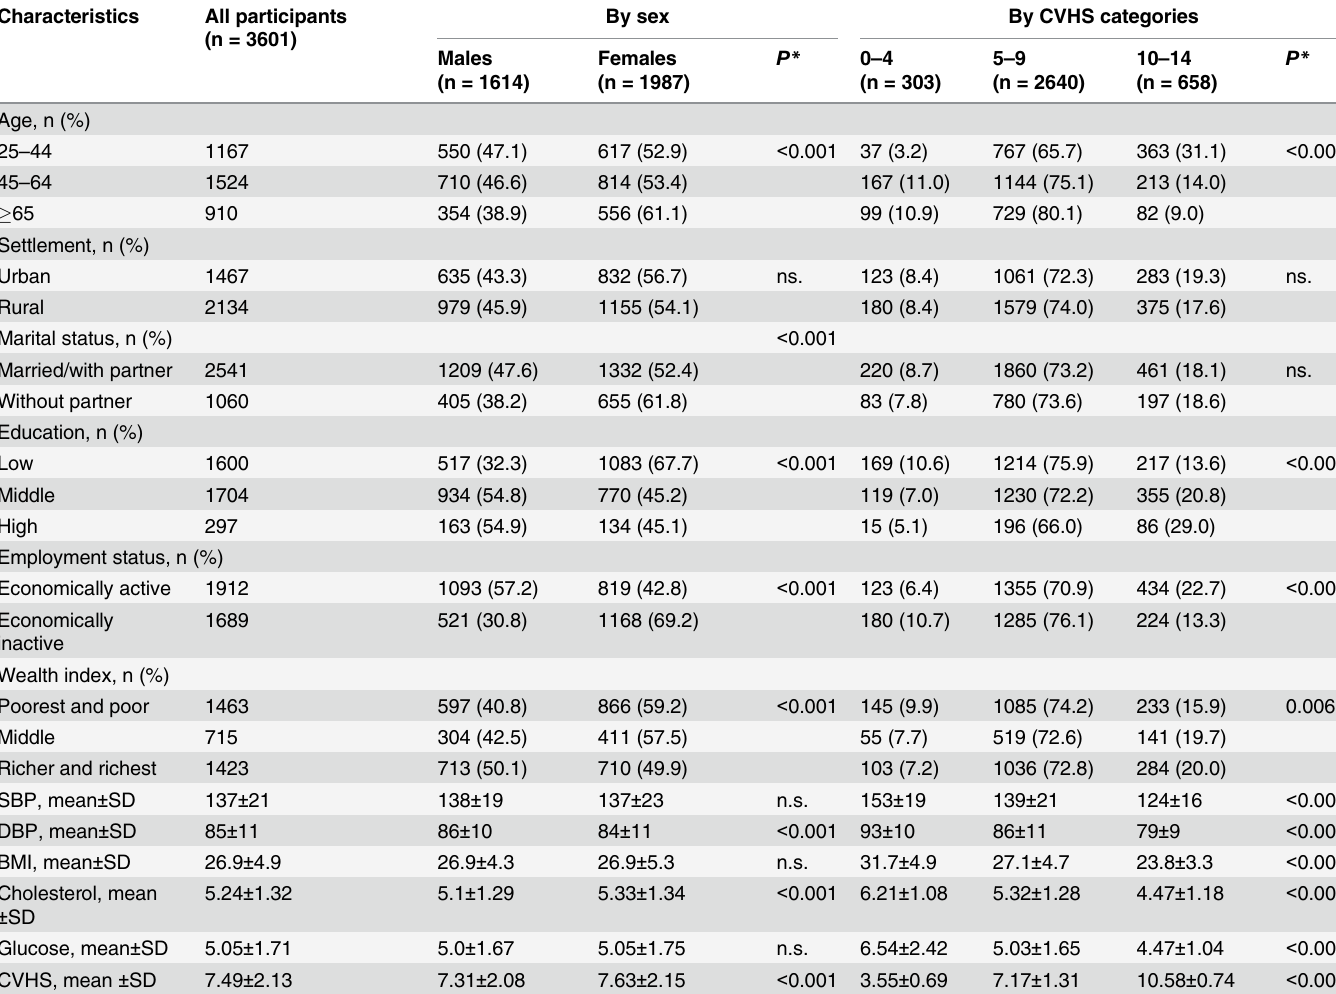
Table 2. Distribution of characteristics of study participants (n = 3601) by sex and cardiovascular health score (CVHS) categories.